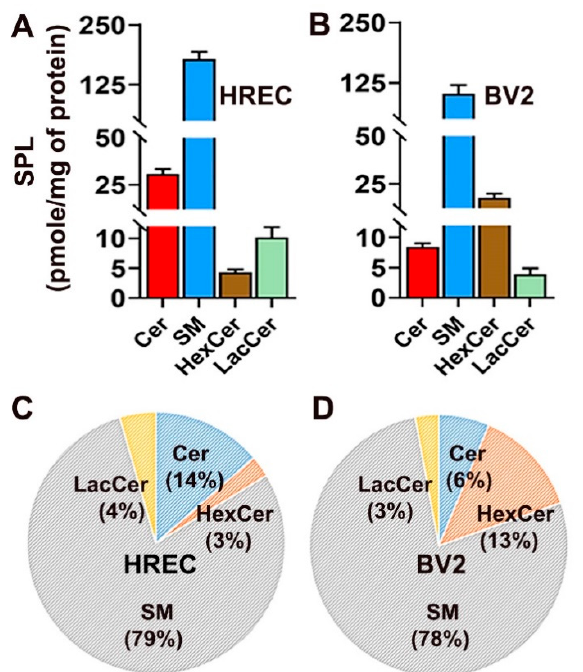
Figure 1. Analysis of major SPL in cultured human retinal endothelial cells (HREC) and murine microglial cells (BV2). Concentration (pmol/mg of protein) of Cer, SM, HexCer, and LacCer in ( A ) HREC and ( B ) BV2 cells cultured for 48 h in 5 mM glucose-containing media. Compositional analysis (mol%) of SPL species ( C ) HREC and ( D ) BV2 cells. Mean ± SEM; n = 3.